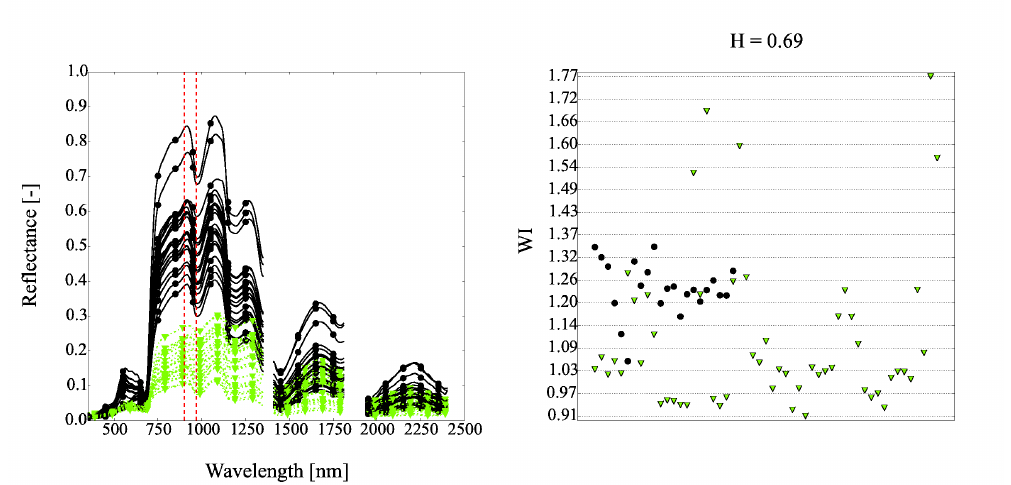
Figure 9. ( Left ) spectral signatures of Sphagnum sp. (SPHA)! (black) and AQ_A (green). Red dashed lines are WI wavelengths; ( Right ) WI values for each vegetation type, H is the Hellinger